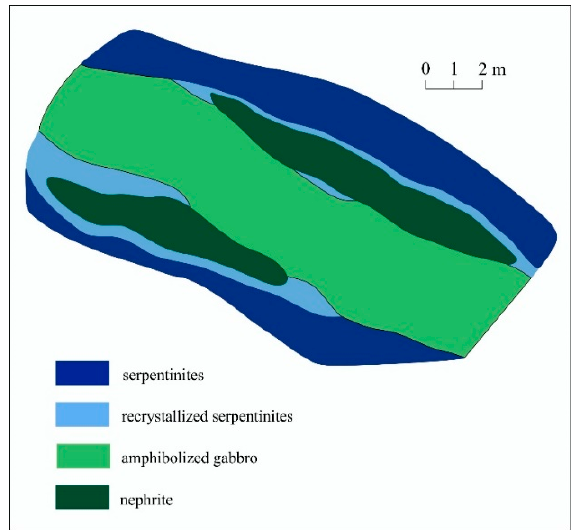
Figure 1. Scheme of the geological position of the nephrite veins of the Ulankhodinskoye deposit according to Suturin and Zamaletdinov [42] with modifications.